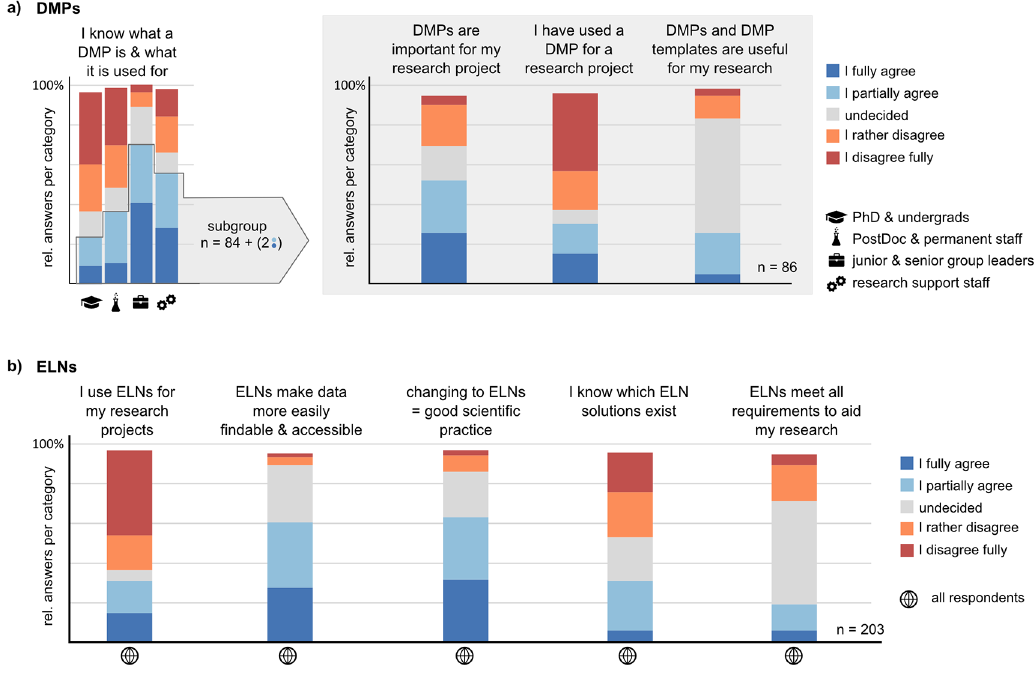
Figure 6. Knowledge and use of Data Management Plans (DMPs) and Electronic Lab Notebooks (ELNs). a) Answers of participants from the four career level groups (undergraduate and PhD students, n = 55; postdoctoral andpermanentresearchers,n=66;juniorandseniorgroupleaders/professors,n=27;researchsupportstaff,n=50) to the statement “ I know what a DMP is and what it is used for ” . The answers to the right-hand statements (grey background) are only shown for participants who stated to know what a DMP is (84 respondents from career level the indicated statements about